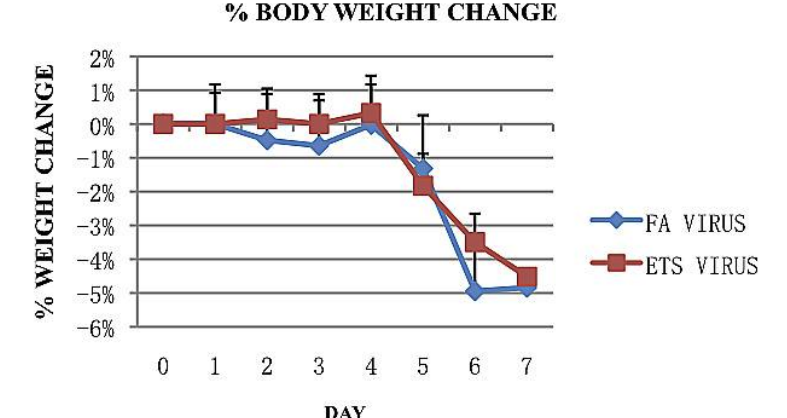
Figure 2. Percent change in body weight following inoculation with influenza A